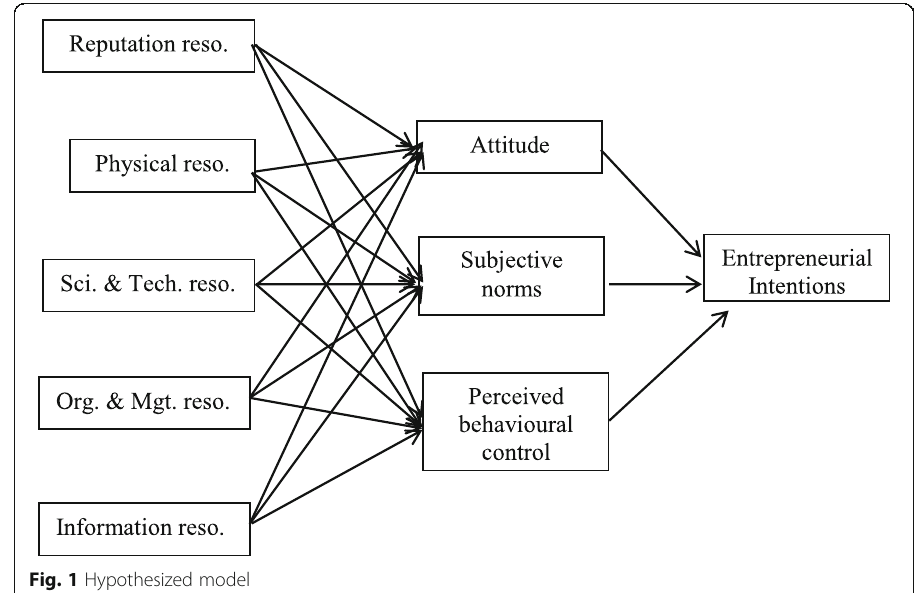
Table 3 path coefficient and hypothesis test for the entrepreneurial intention